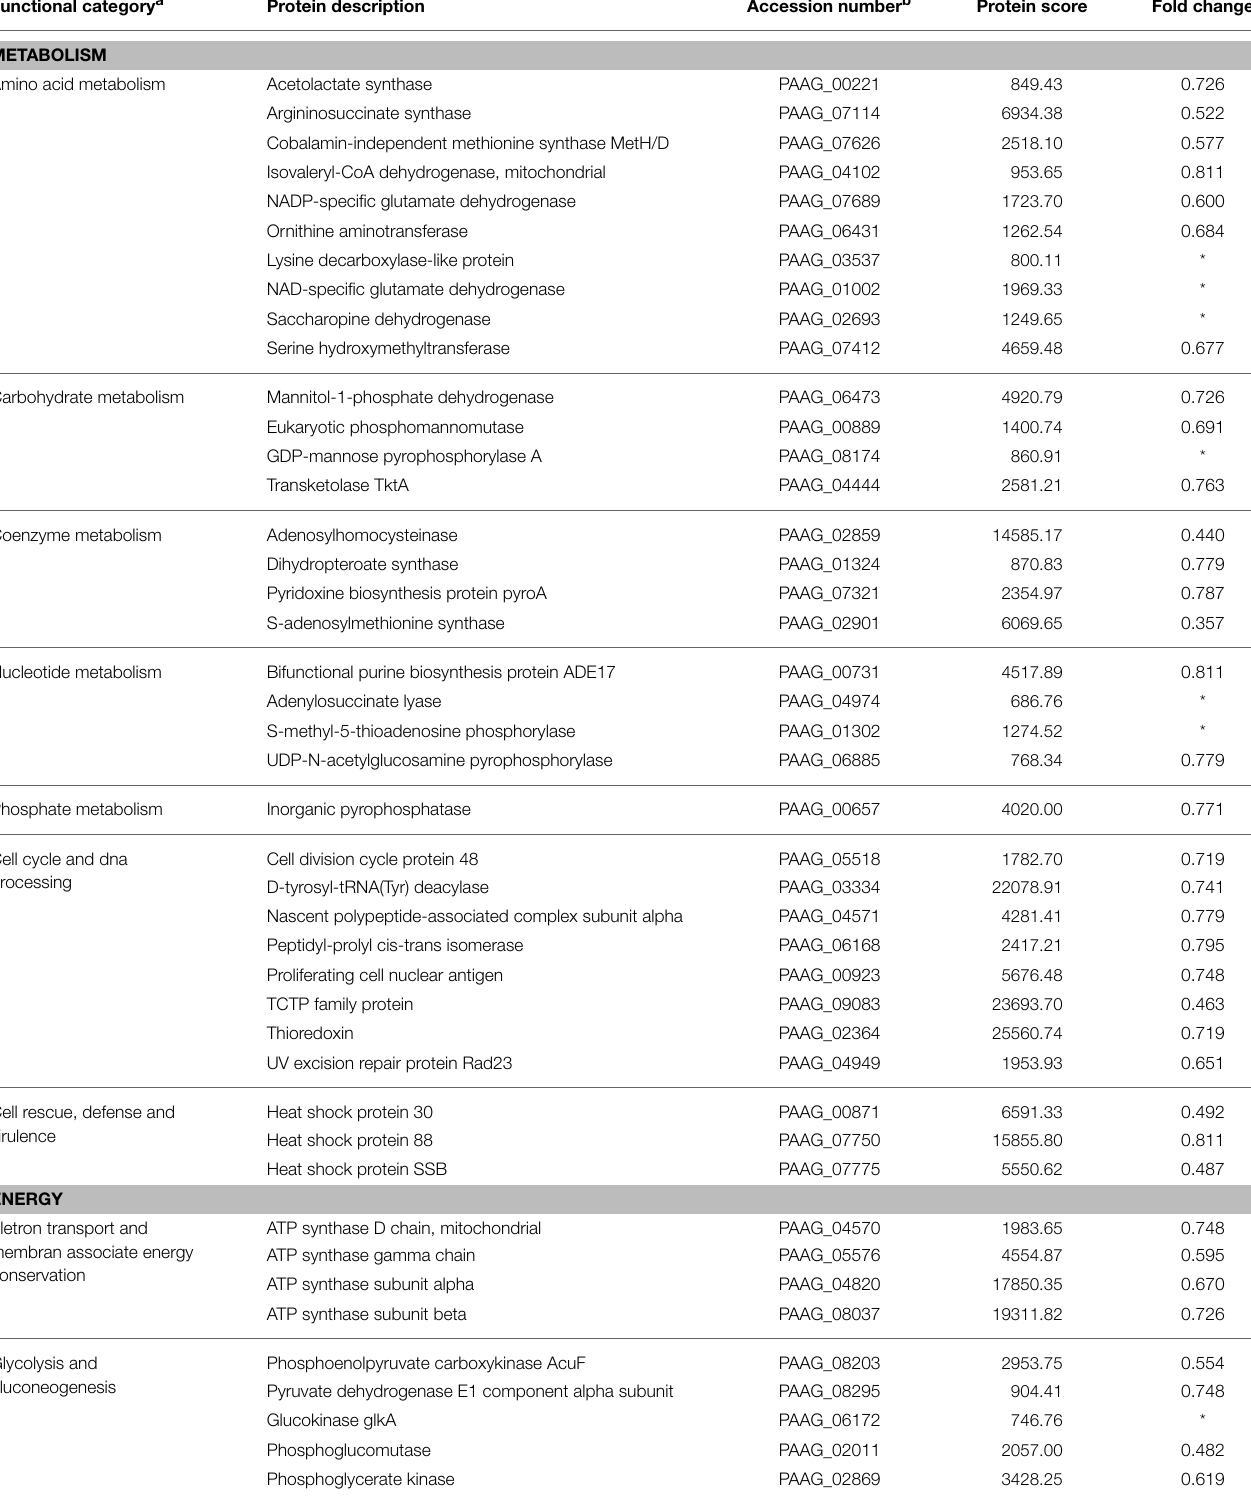
TABLE 2 | P. lutzii less abundant proteins after incubation with argentilactone. Functional category